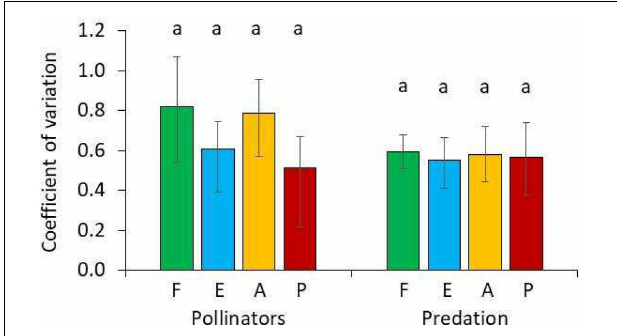
FIGURE 5 | Coefficients of the variability of pollinator activity (all color traps combined) and arthropod predation (bite marks) in the forest (F, green), the forest edge (E, blue), the agricultural fields (A, orange), and the tree plantation (P, red). Identical letters in above the bars indicate lack of statistically significant differences in pair-wise U-tests after one-way Kruskal–Wallis ANOVA at P < 0.05. Error bars denote bootstrapped 95% confidence limits.